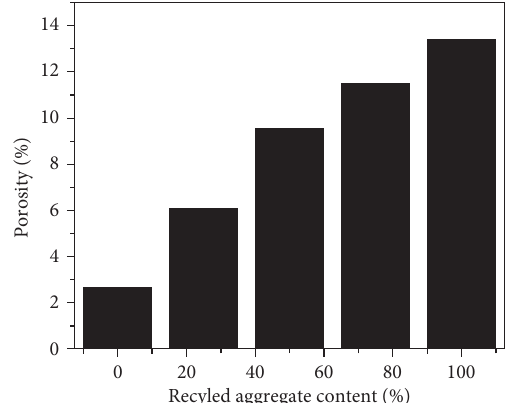
Figure 10: The curve of the porosity.